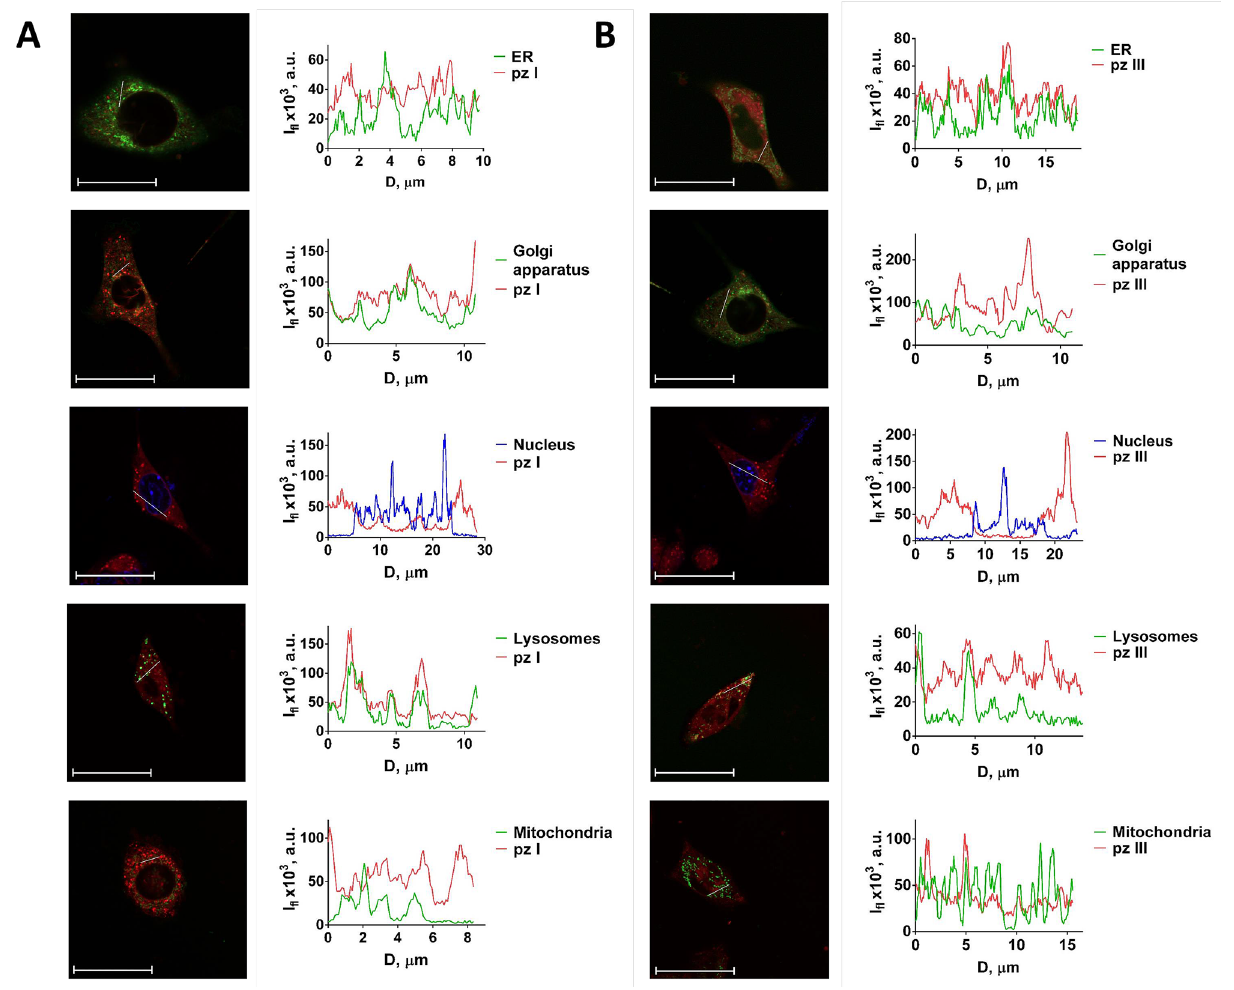
Figure 2. Analysis of subcellular distribution of pz I and pz III by confocal microscopy. The subcellular localization of pz I ( A ) and pz III ( B ) was studied by confocal microscopic examination of fibrosarcoma MCA205 cells after 4 h of incubation with 10 μM of the photosensitizers. Pz I localizes primarily in the Golgi apparatus and partially in the lysosomes ( A ), while pz III accumulates mainly in the ER, and there is a connection with lysosomes ( B ). Fluorescence signal profiles along the lines are indicated by the white arrow on the images with superimposed fluorescence channels. D: distance along the specified segment. Ifl: fluorescence intensity. The following dyes were used: LysoTracker Green (lysosomes), MitoTracker Green (mitochondria), ER-Tracker (ER), BODIPY FL C5-ceramide (Golgi apparatus), and DAPI